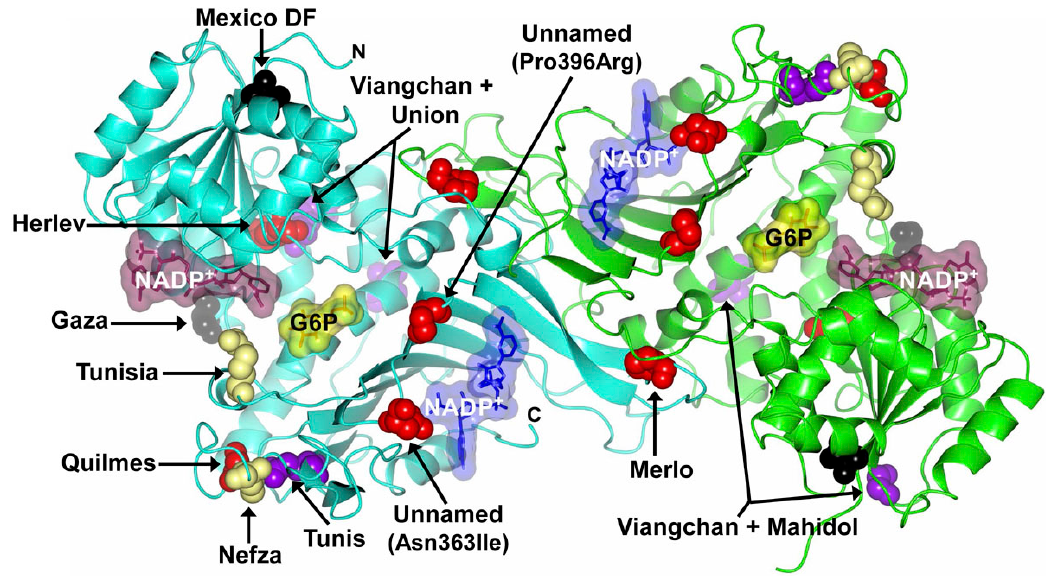
Figure 5. Recent described mutations in the G6PD protein. Structure of human WT G6PD enzyme (PDB entries 2BHL and 2BH9) indicating the location of Class I–IV mutations (missense variants) in the dimer. The Class I, II, III, and IV mutations are shown as red , purple , yellow , and brown spheres, respectively. The unnamed reported class mutations are shown as black spheres. Note that although most of the mutants are located on equivalent positions of G6PD dimer, Viangchan + Mahidol and Viangchan + Union mutants are shown in only one of the monomers. The figure was prepared using CCP4mg [28].